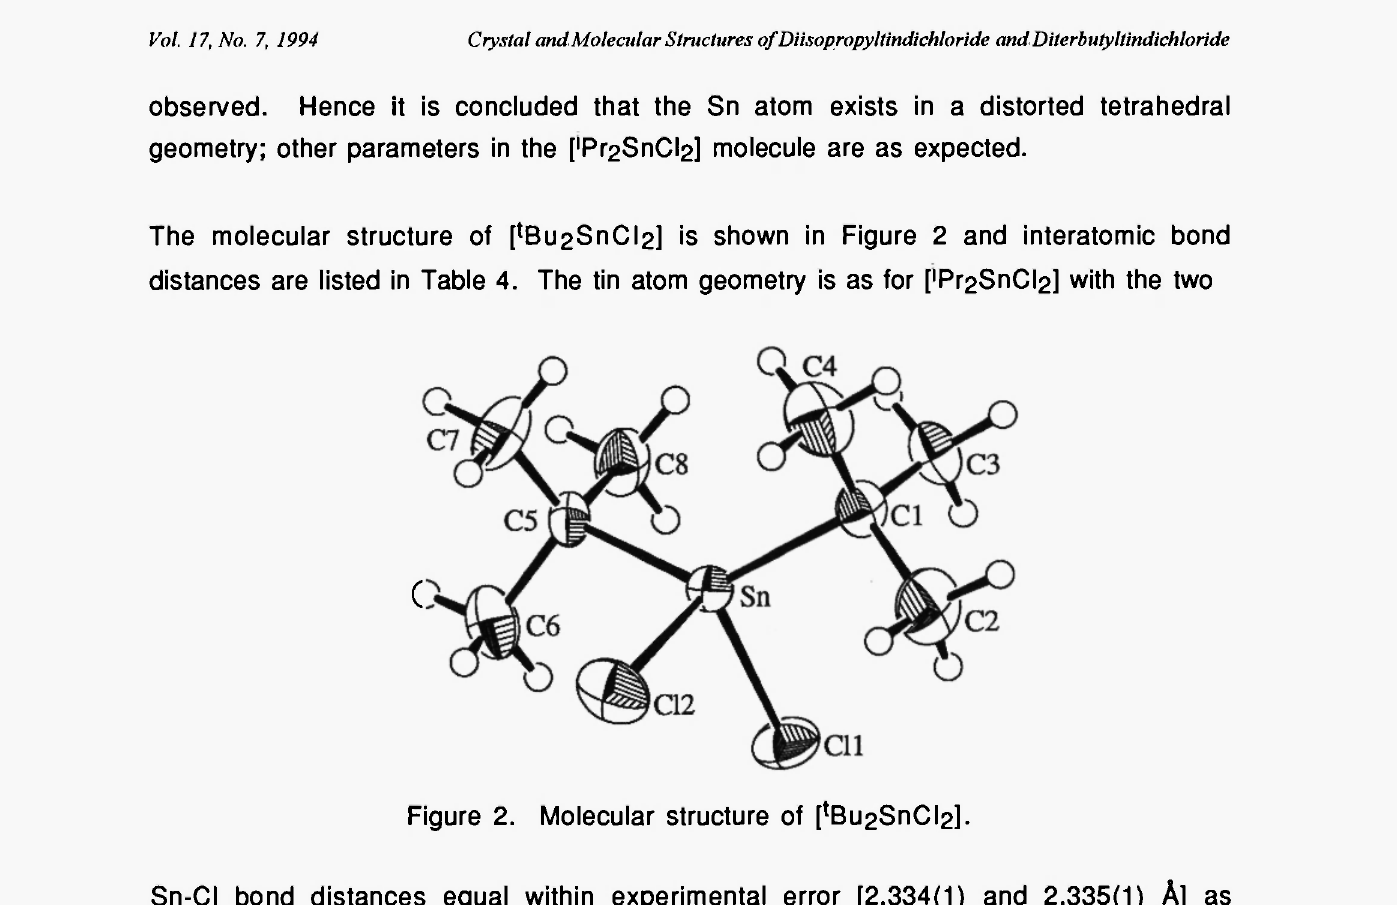
Figure 2. Molecular structure of [ l